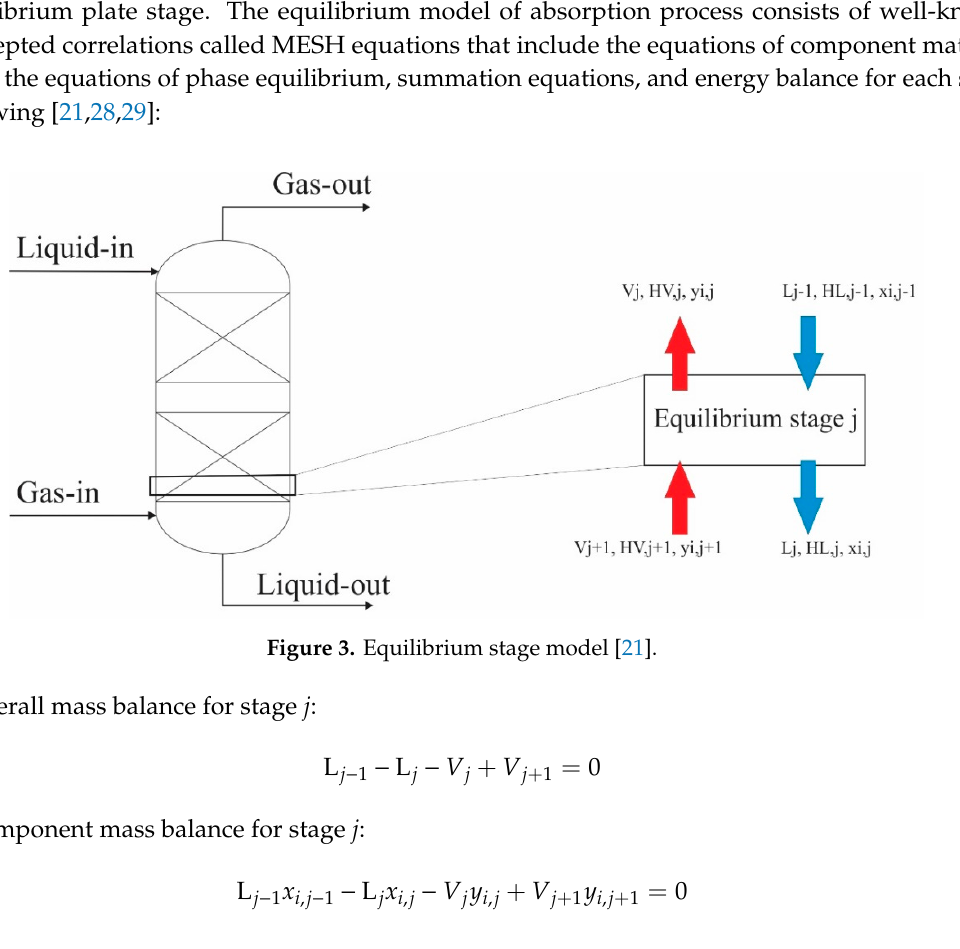
Figure 3. Equilibrium stage model [21].